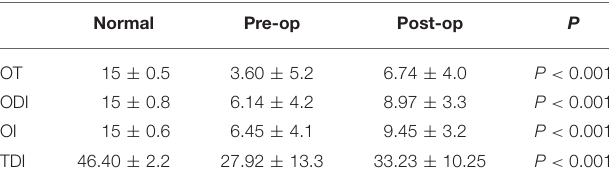
TABLE 2 | DBS improved olfactory function scores with different parameters. Normal Pre-op